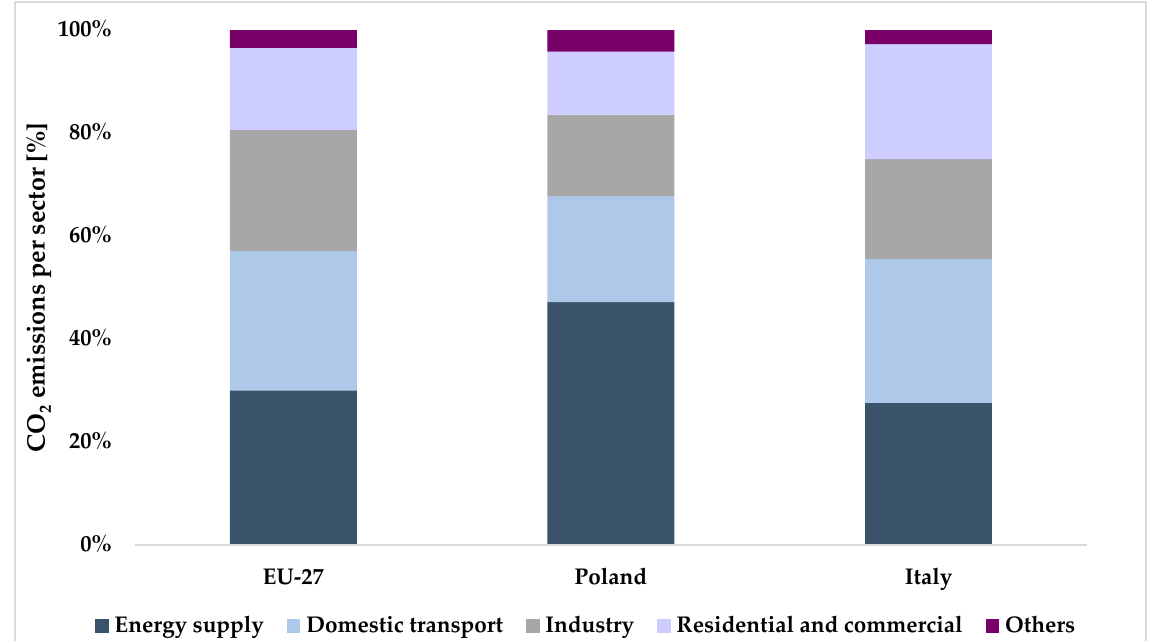
Figure 1. CO 2 emissions by sector in EU-27, Poland, and Italy. Data elaborated from [6].